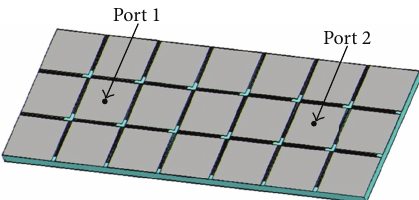
Figure 4: Setup used to extract the suppression band and the power loss parameter of EBG structures. The port locations are shown in the figure.